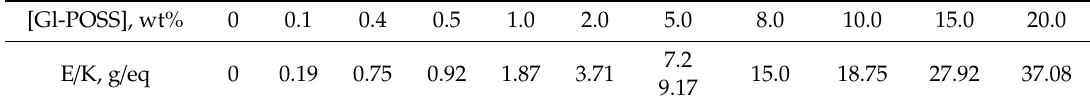
Table 1. The ratio of [~ О − К + ] and [ ] groups